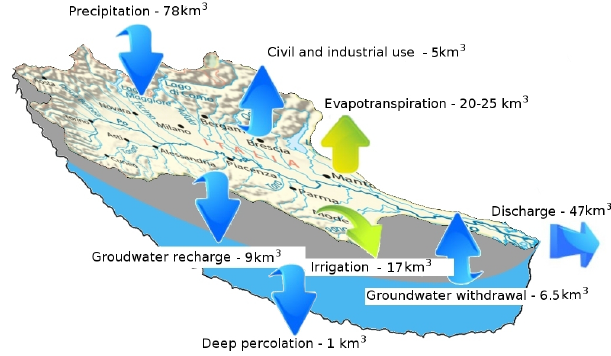
Fig. 3. Mean annual main hydrological fluxes for the Po River